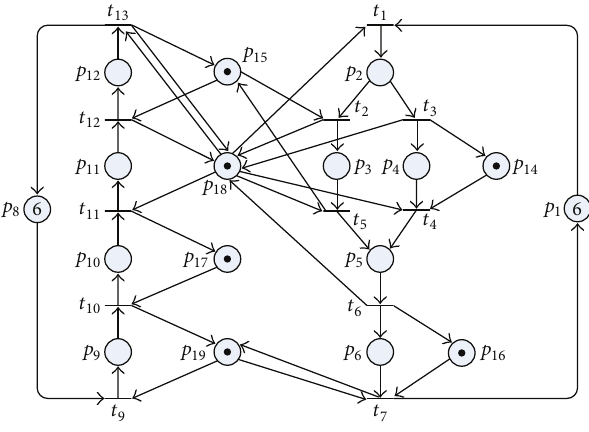
Figure 3: The reduced model of Figure 2.